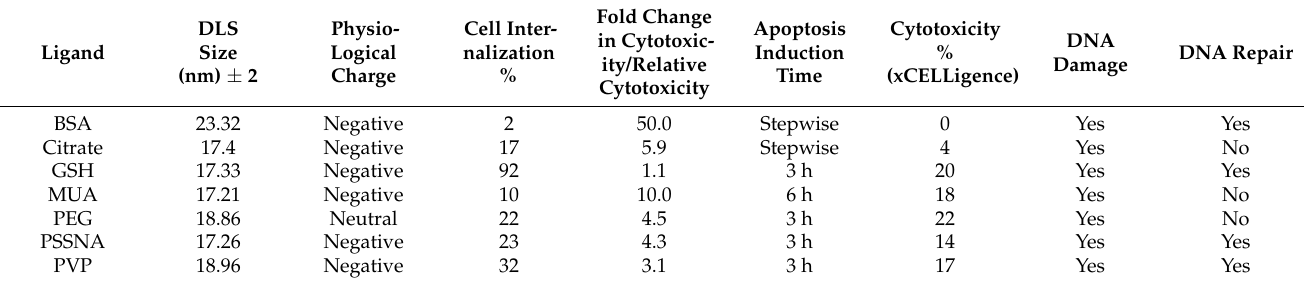
Table 4 is a collective table of the information obtained for the GNP-ligands over the various parameters examined. Table 4. Comparison of GNP-ligand physical parameters and their effect on HepG2